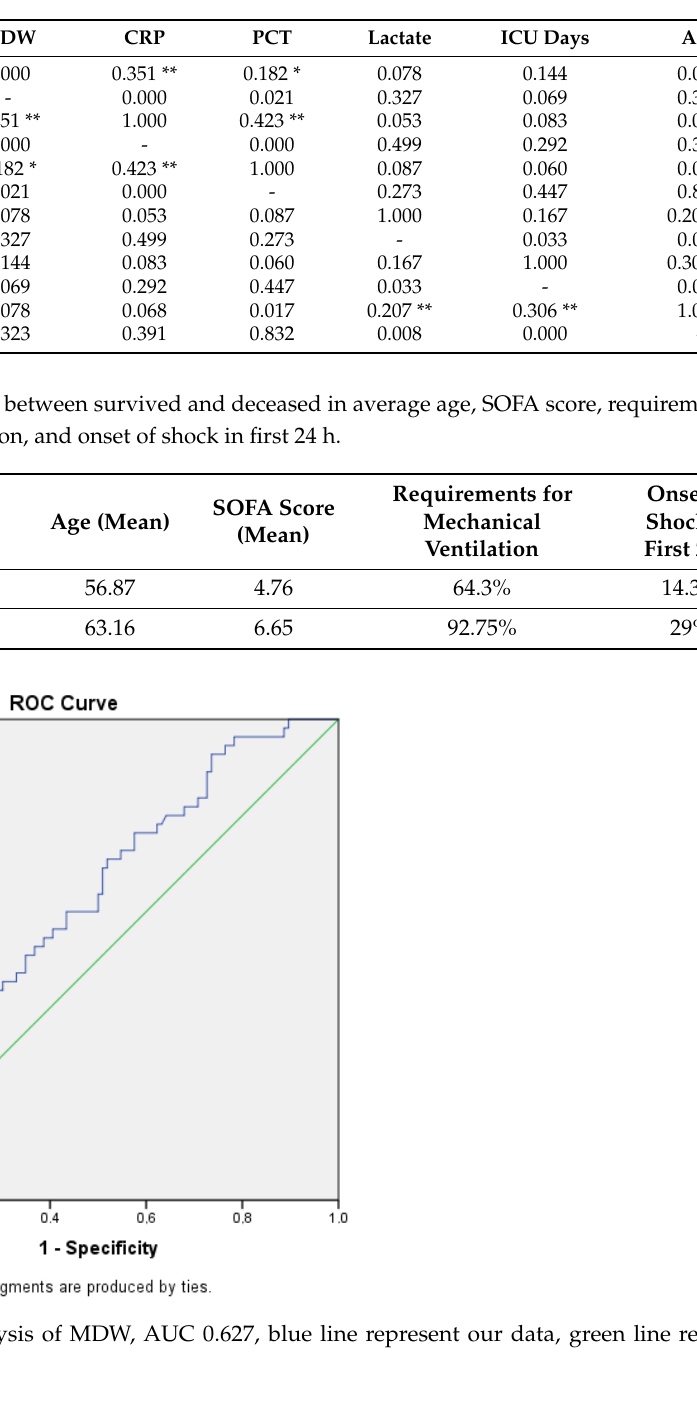
Table 4. Correlation between variables, * for p < 0.05; ** for p < 0.01.